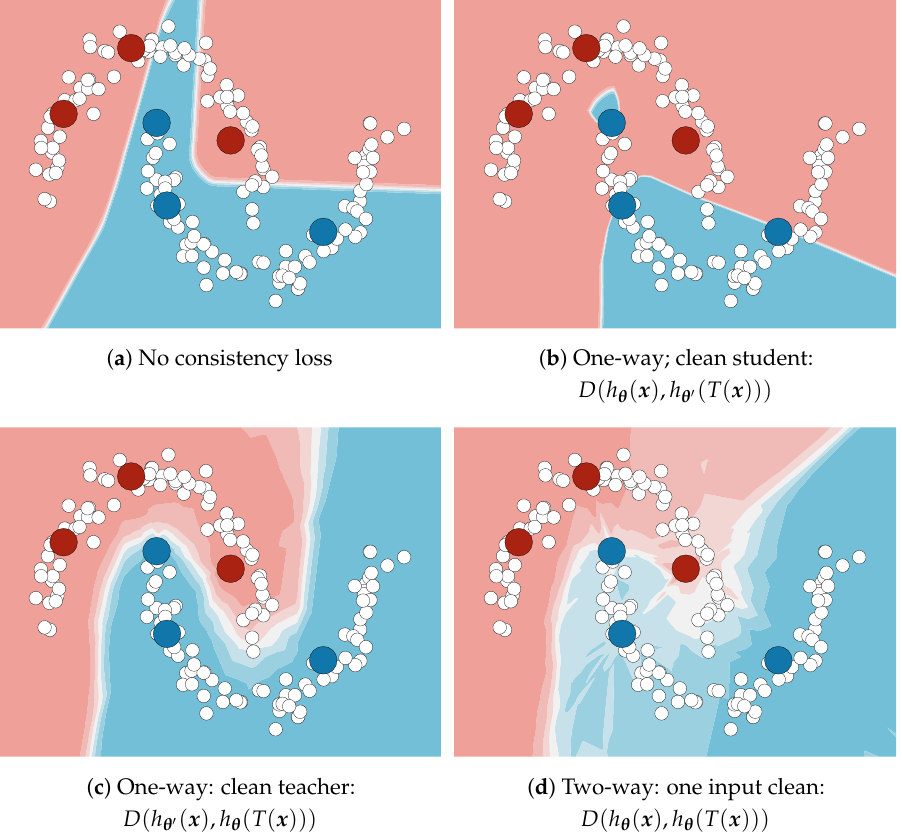
Figure 1. A toy semi-supervised classification problem with six labeled (red, blue) and many un- labeled 2D datapoints (white). All setups involve 20,000 epochs of semi-supervised training with cross-entropy and default Adam optimization hyper-parameters. The consistency loss was set to none ( a ), one-way with clean student ( b ), one-way with clean teacher ( c ), and two-way with one input clean ( d ). One-way consistency with clean teacher outperforms all other